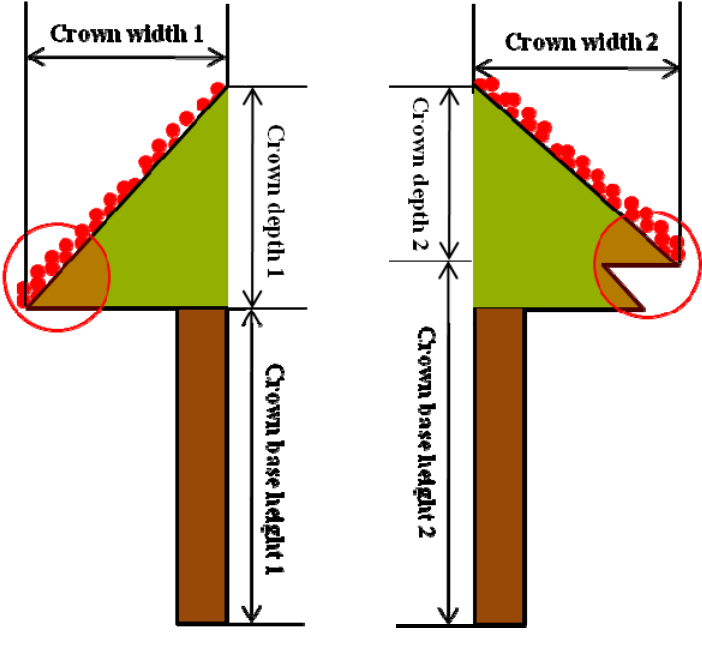
Figure 10. Misinterpretation in measuring CBH due to obstruction by higher branches when ALS data are